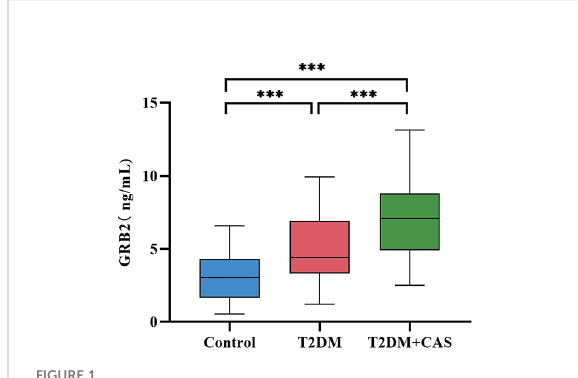
FIGURE 1 Comparison of the Serum GRB2 levels between the Control group, the T2DM group, and the CAS group. The differences were statistically signi fi cant.